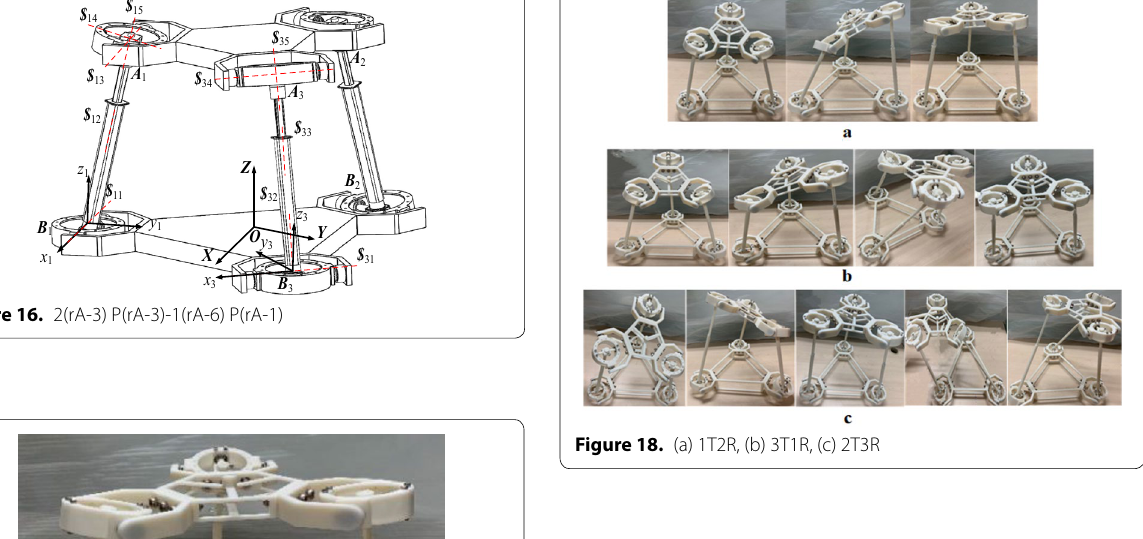
Table 1. Phases and DOF of limb